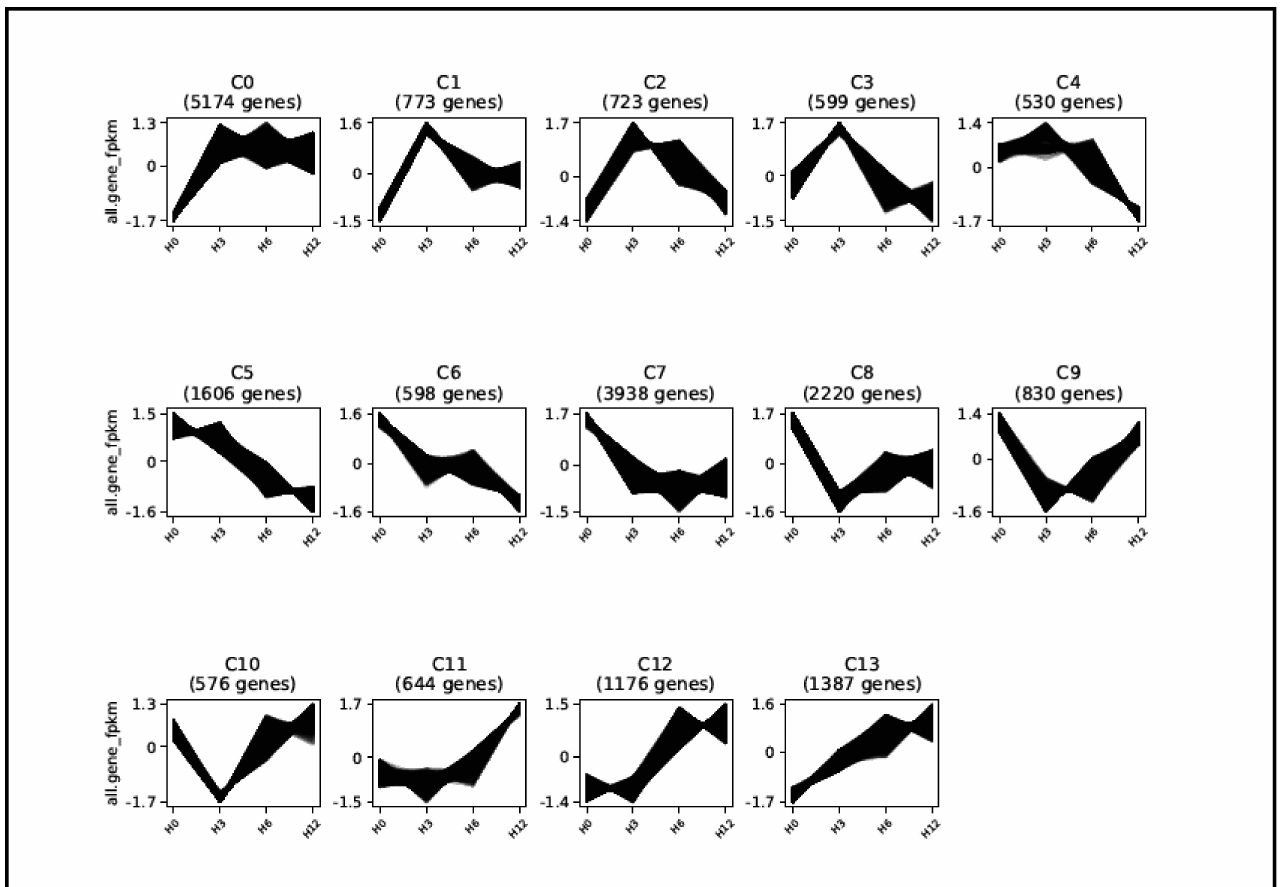
Figure 5. SCR96-responsive genes could be clustered based on temporal expression patterns. SCR96-responsive genes were clustered using Clust according to their expression kinetics. Fourteen major clusters were obtained. The temporal expression profiles of the genes in each cluster are represented by line graphs. The y-axis of each graph shows the normalized expression value of each gene in FPKM, and the x-axis represents the corresponding time points (H0, H3, H6, and H12 mean 0, 3, 6, and 12 h) after SCR96 treatment. The numbers in parentheses are the numbers of genes within each